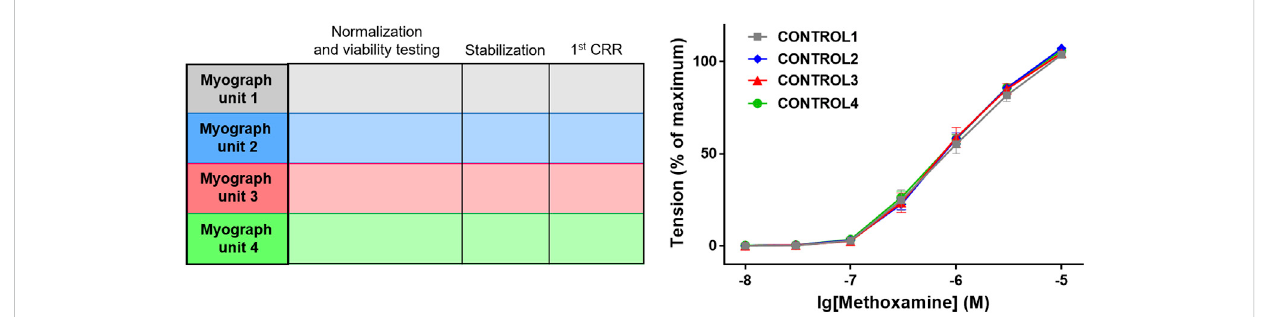
FIGURE 1 Control for similarity of initial contractility. As an example, the protocol of an experiment is shown in which4 groups of blood vessels will bestudied in myograph units 1 – 4. After the initial distension (i.e., normalization) and the starting procedure (i.e., viability testing) the effect of the contractile agonist methoxamine is tested by determining its concentration-response relationship (CRR) (protocol scheme shown in the left panel). As shown in the right panel, vessel tension in the 4 different experimental groups (CONTROL1 — CONTROL4) were not different ( n = 7; p = 0.94 based on the area under the concentration-response relationships). Reproduced and modi fi ed with permission from (Schmid et al., 2018).